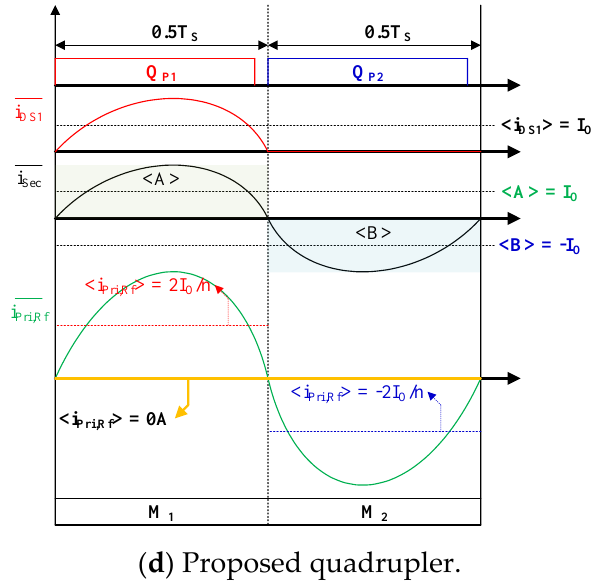
Figure 3. Simplified primary and secondary currents in resonant operation.